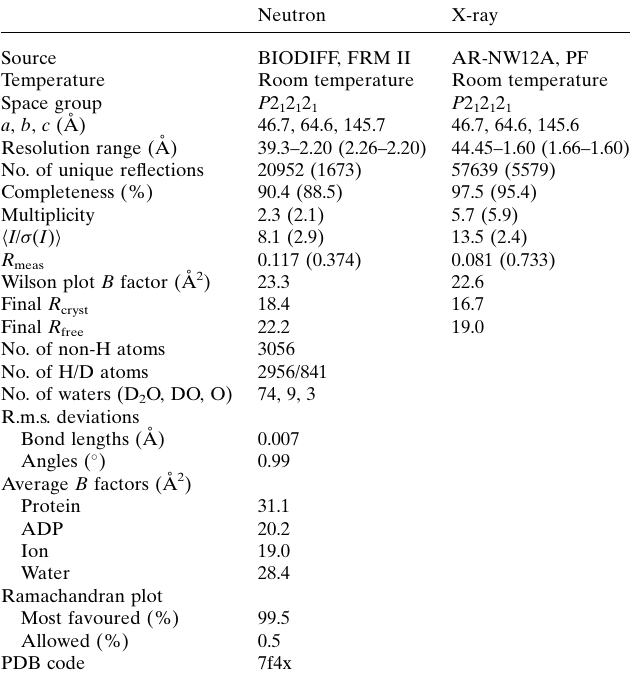
Table 2 Statistics for the joint XN refinement of the NBD of